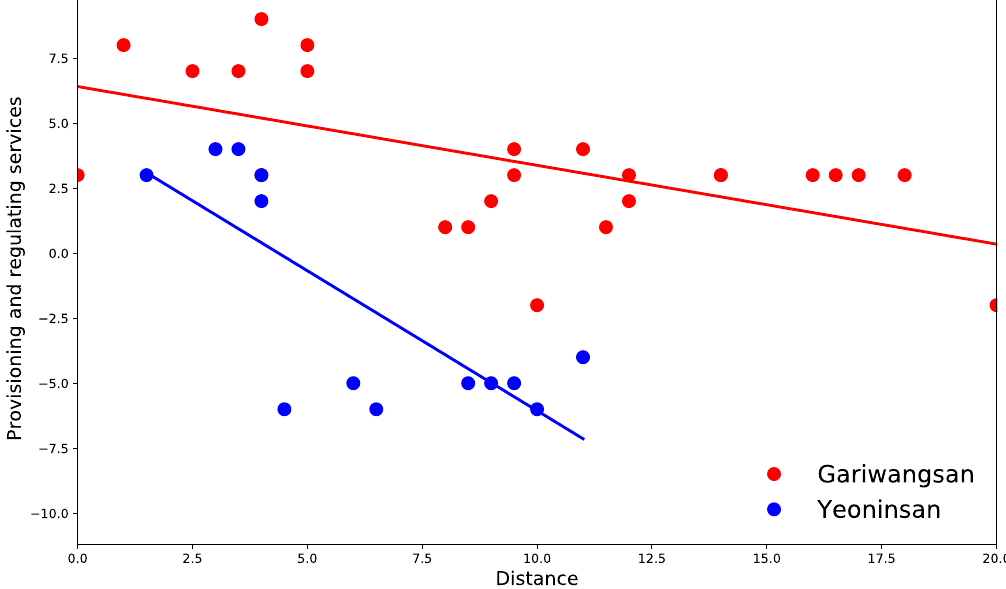
Figure 3. Relationship of provisioning and regulating ES categories in Gariwangsan and Yeoninsan.